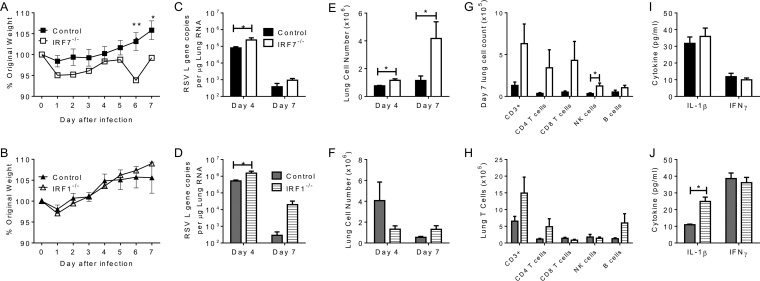
IRF7, but not IRF1, is important in the control of RSV infection. IRF7−/− (A, C, E, G, I) or IRF1−/− (B, D, F, H, I) mice were infected with 5 × 105 PFU of RSV strain A2 and compared to wild-type controls on the same background. Mice were weighed daily, and weight changes were recorded as percentages of the original weight (A, F). Lungs were excised, and viral loads were calculated by quantitative PCR on days 4 and 7 postinfection (B, G). Total lung cell counts (C, H) were calculated, along with the total numbers of CD3, CD4, and CD8 (T); CD19 (B); and DX5+ (NK) (D, I) cells measured in the lungs by flow cytometry on day 7 postinfection. Levels of the inflammatory cytokines IL-1β and IFN-γ in the lungs (E, J) were measured by enzyme-linked immunosorbent assay on day 7 postinfection. Results are mean values ± the standard error of the mean (n >5). Statistical significance was assessed by Student t test (*, P < 0.05; **, P < 0.01; ***, P < 0.001).